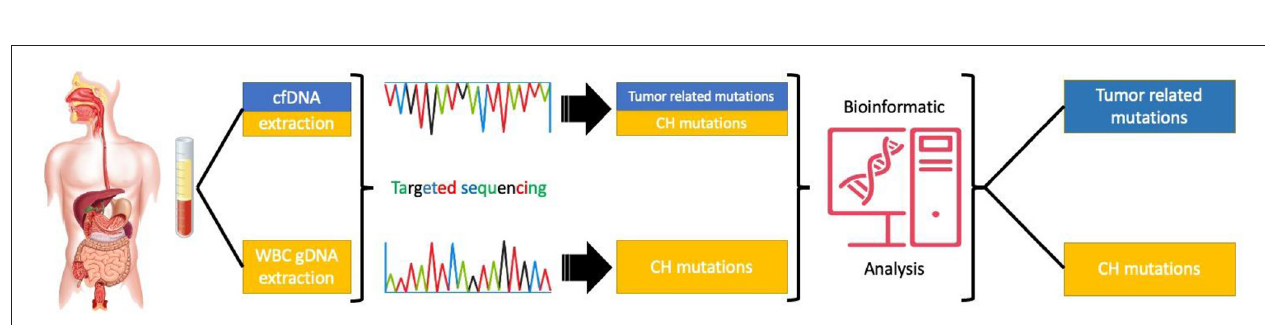
FIGURE 2 | Targeted sequencing of paired cfDNA and white blood cells to correctly asses the origin of the mutations.